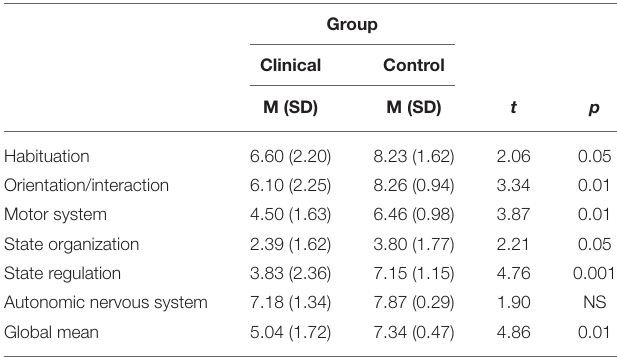
TABLE 3 | Means for the Brazelton neonatal behavioral assessment scale and comparison of the two